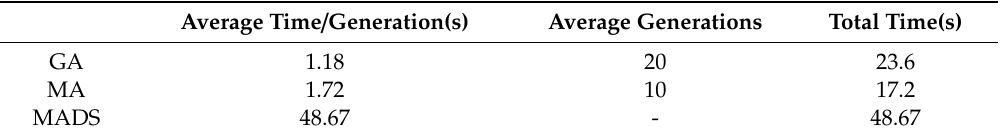
Table 4. Computational cost of the